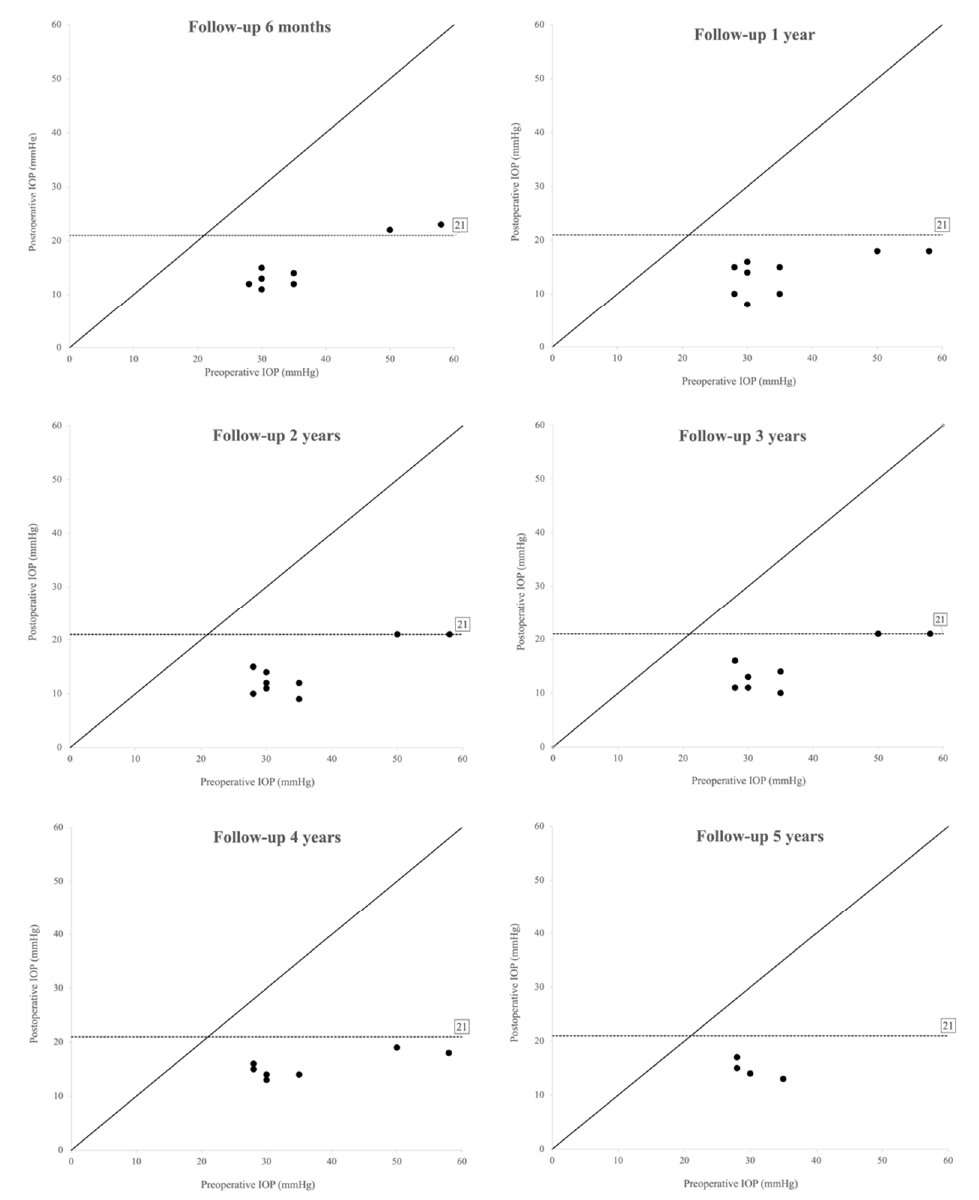
Figure 4. Scatterplot of preoperative ( X axis) and postoperative ( Y axis) intraocular pressure (IOP) (mmHg) at six months, one, two, three, four, and five years after surgery. The value of IOP for each operated eye is represented with a black dot. The dashed line indicates the 21 mmHg value. Equality between preoperative and postoperative measurements is represented with a solid line.